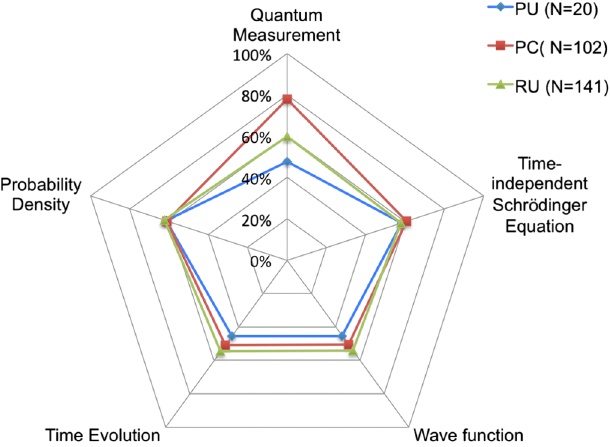
FIG. 8. The student scores on five concept categories of QMCA show larger variation in students ’ performances on questions related to quantum measurement. However, students ’ scores on all the other four-concept categories are practically the same. The standard error of the mean for concept category for any institutional type (i.e., each data point in the figure) fluctuated